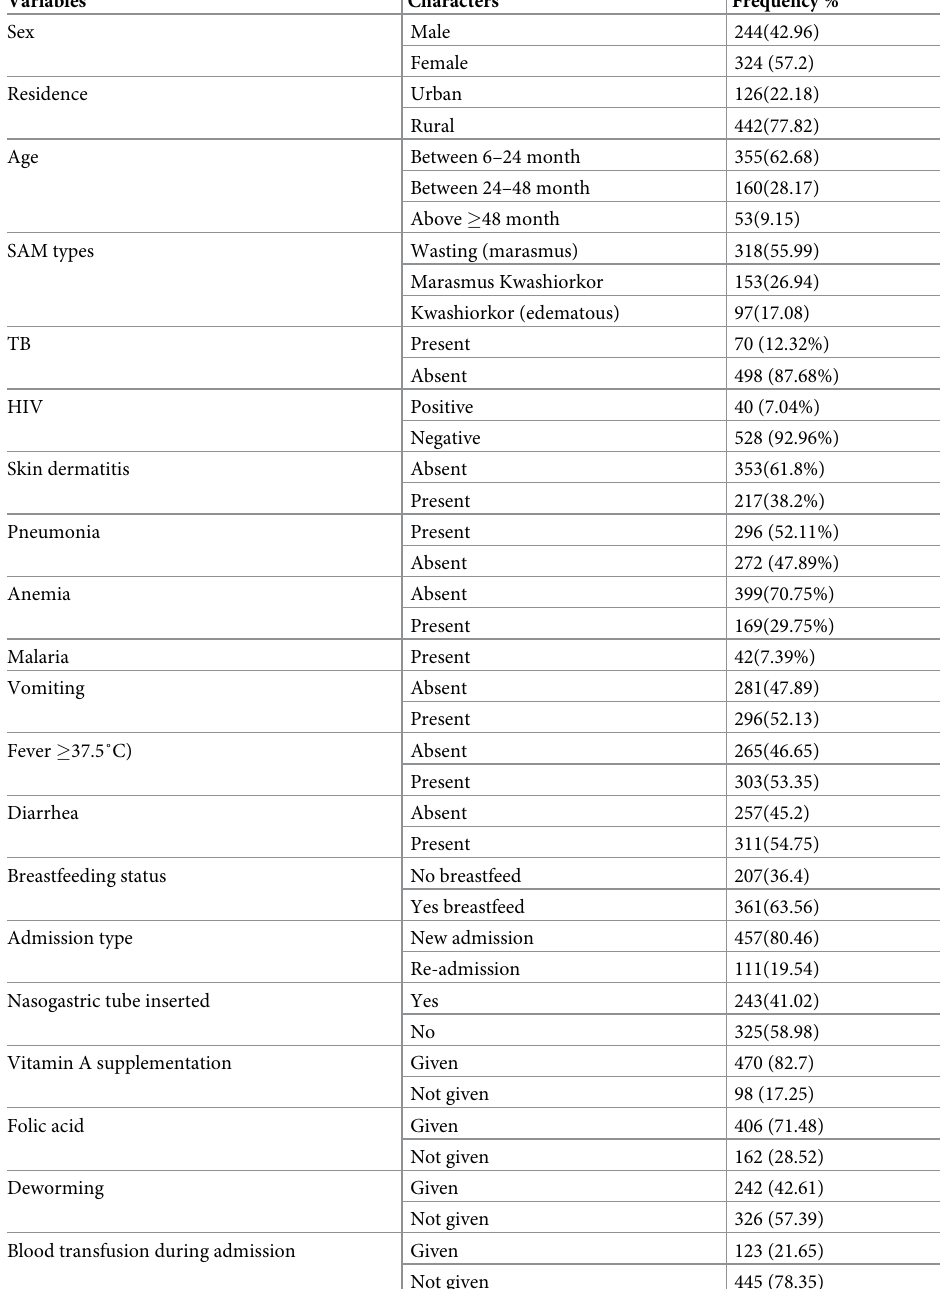
Table 1. Baseline socio-demographic characteristics of 568 severe acute malnutrition admitted children in Pawe general hospital from